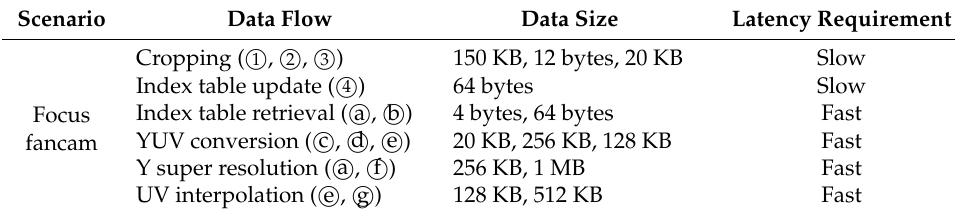
Table 1. The requirements of each dataflow in the focus fancam scenario.